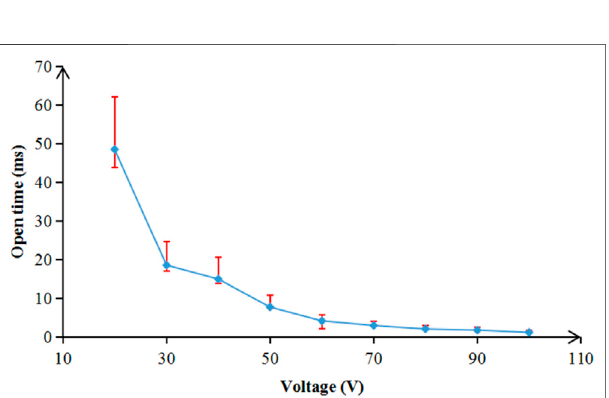
FIGURE10| The relationshipbetweendriving voltage and pixelopening time. The dot in the fi gure represented the response rising time of the pixel whentheapplieddrivingvoltagewasfrom20to100 V.Thepixelopeningtime was decreased exponentially with the increase of driving